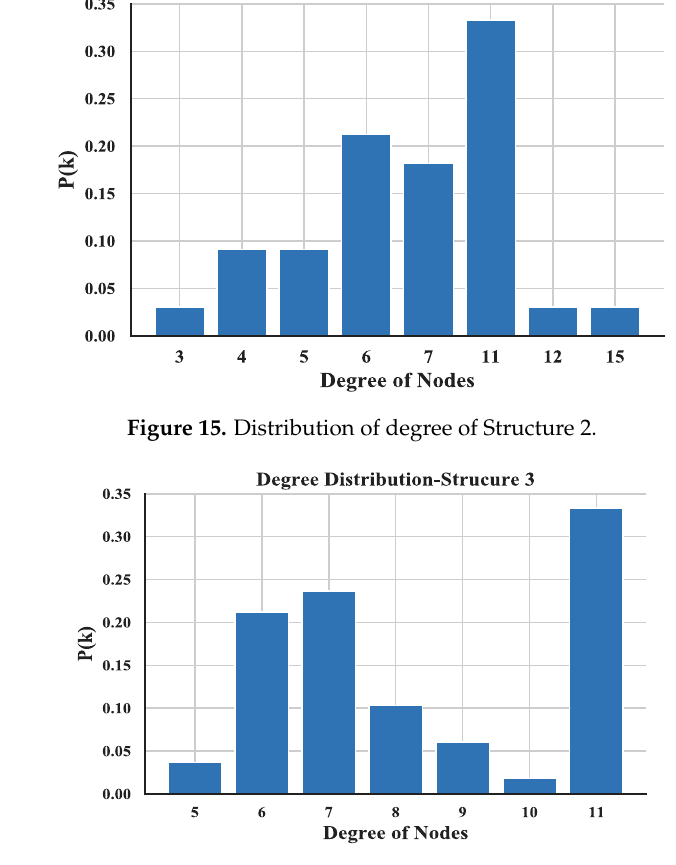
Figure 16. Distribution of degree of Structure 3.